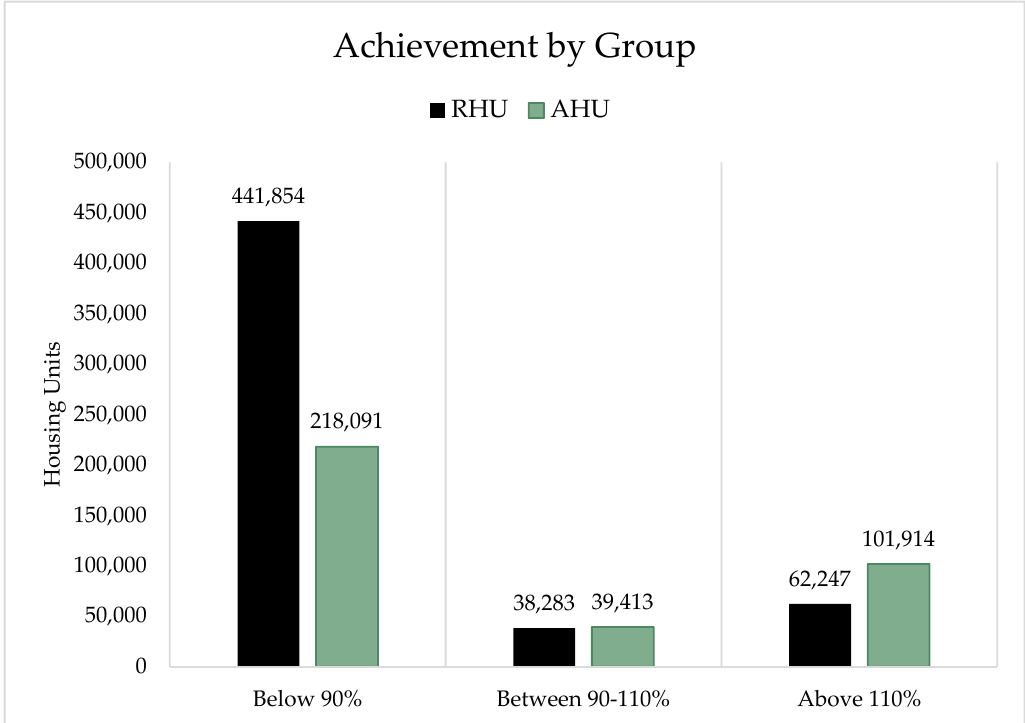
Figure 6. Achievement by group. The sample’s 185 cities were placed in three groups as determined by the proportional achievement of added housing units (AHU) to RHNA Households (RHH). The cities in the below 90% group added 218,091 housing units but had a goal of 441,854 housing units. Hence, their average achievement was 49.4%. Sources. SCAG, California’s Department of Finance.